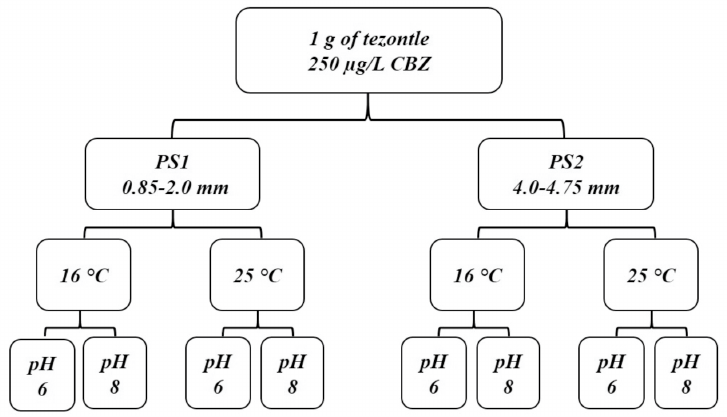
Figure 1. Experiment design for the adsorption kinetic assays of carbamazepine (CBZ) on tezontle without biofilm.